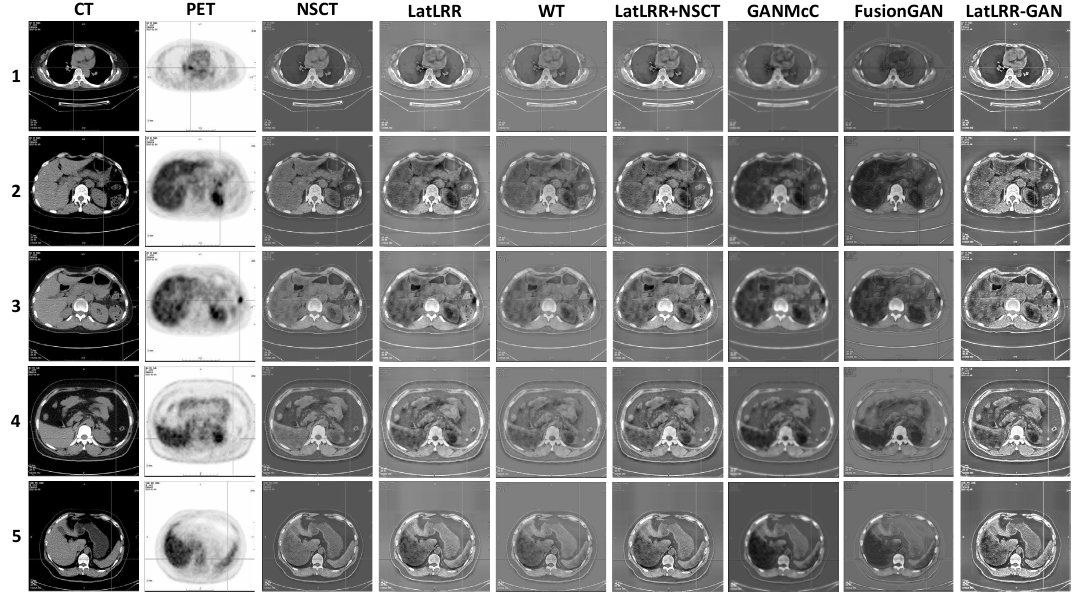
Figure 5. The fusion results of CT mediastinal window images and PET images. Method 1: NSCT; Method 2: LatLRR; Method 3: WT; Method 4: LatLRR+NSCT; Method 5: GANMcC; Method 6: FusionGAN; Method 7: LatLRR-GAN.